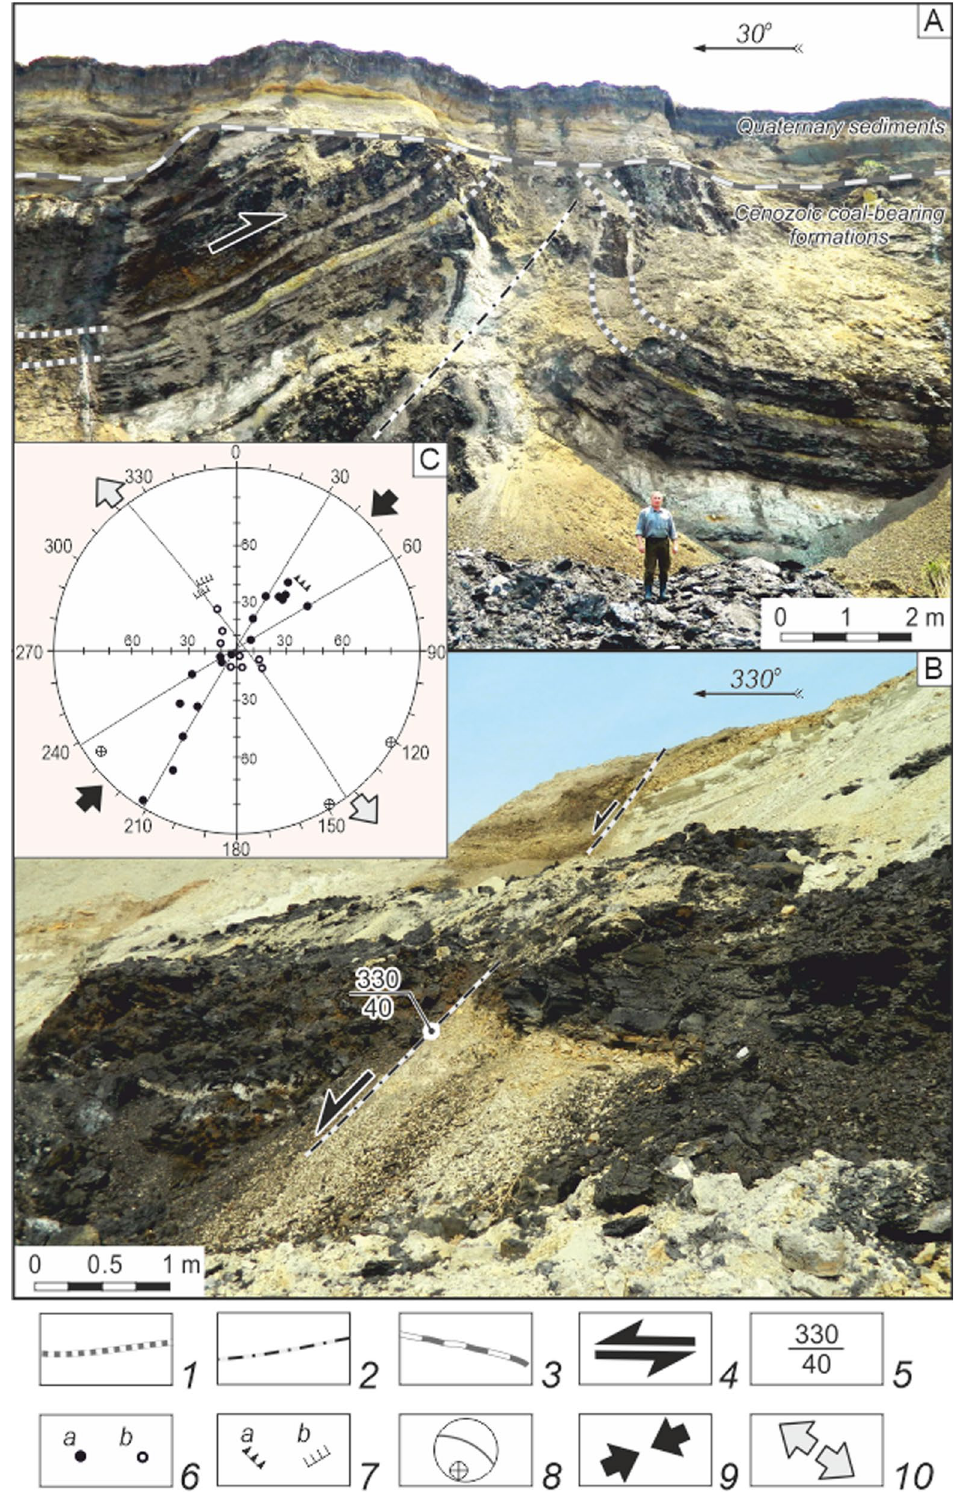
Fig. 2 Longitudinal compression a and extension b deformations formed by the northeastern (30°–60°) stress field. The diagram of structural elements c : 1—marker clay interlayers; 2—faults; 3— angular unconformity; 4—displacement direction; 5—elements of the fault plane: azimuth (numerator) and angle (denominator) of